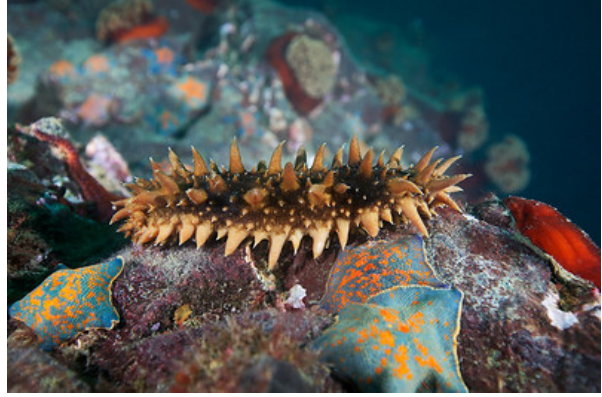
Figure 25. A specimen of Stichopus japonicus . © Alexander Semenov; https://www.flickr.com. Isostichopus badionotus (Selenka, 1867; Holothuroidea, Synallactida: Stichopodidae; Figure 26)